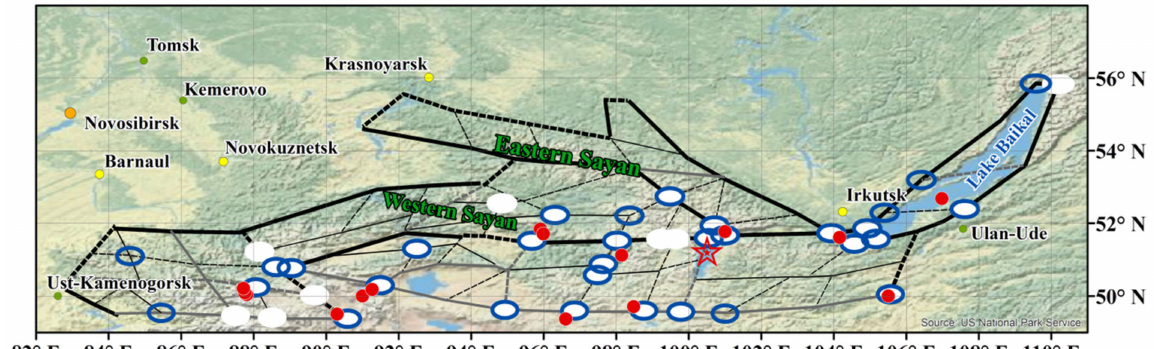
Figure 2. The morphostructural zoning map of the Altai–Sayan–Baikal region. Thick black lines—rank I lineaments; medium gray lines—rank II; thin black lines—rank III; solid lines—longitudinal lineaments; dotted line—transverse ones [36,37], areas prone to earthquakes with M ≥ 6.0 (ellipses with blue boundaries—Barrier-3 [16], white ellipses—Cora-3 [37], white ellipses with blue boundaries—both the algorithms). Red circles designate the epicenters of crustal earthquakes with M ≥ 6.0 (1900–2012) used to form the learning set B 0 , red star refers to the epicenter of crustal earthquake (11 January 2021 with M = 6.7) that occurred after the completion of recognition.